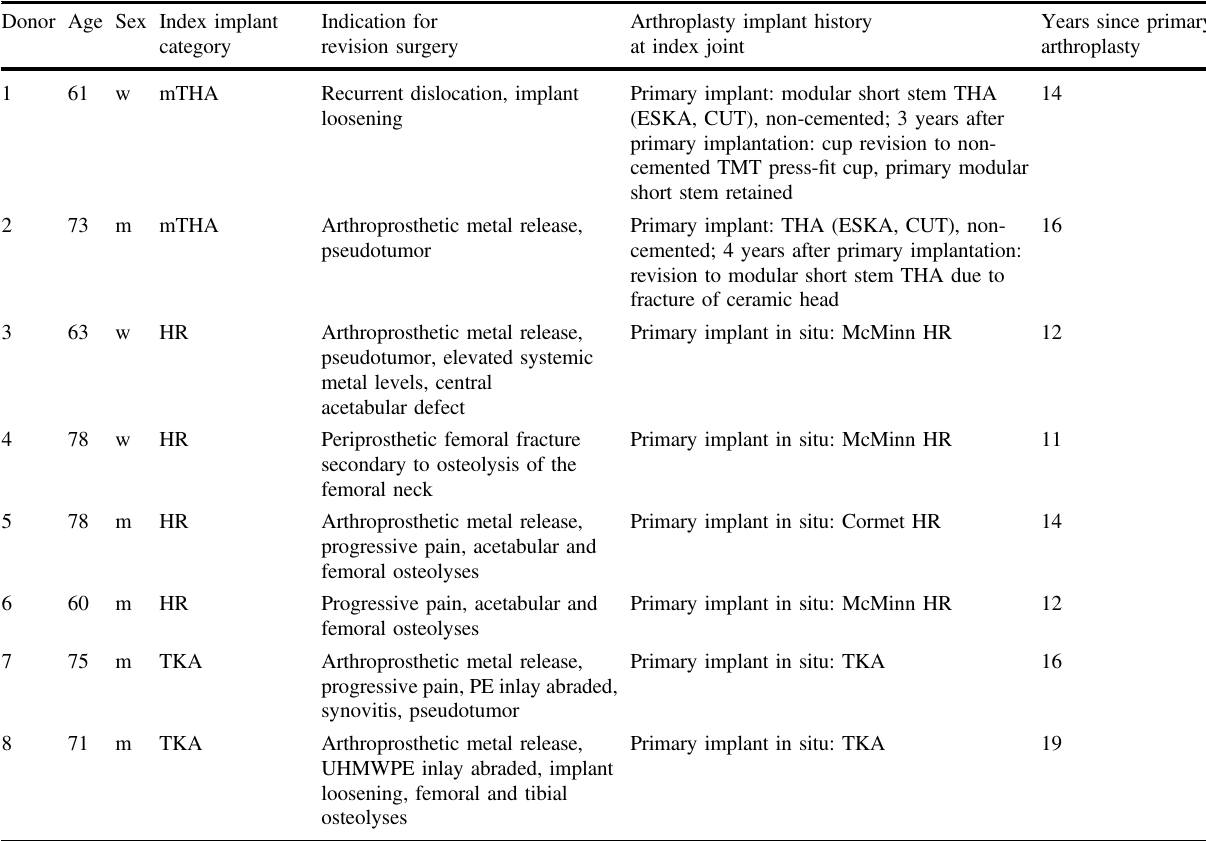
Table 1 Patient and implant data Donor Age Sex Index implant Indication for category revision surgery